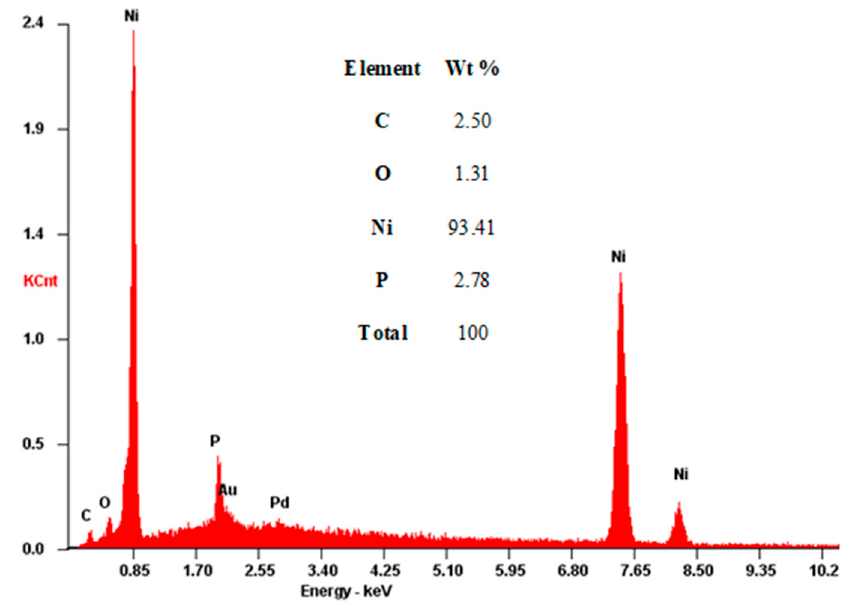
Figure 11. EDS spectrum of a Ni-P plated sample at 40 °C for 60 min.